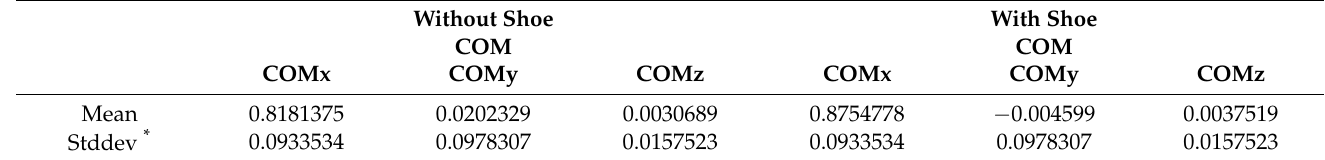
Table 2. Mean and standard deviation of COM variables (velocity).